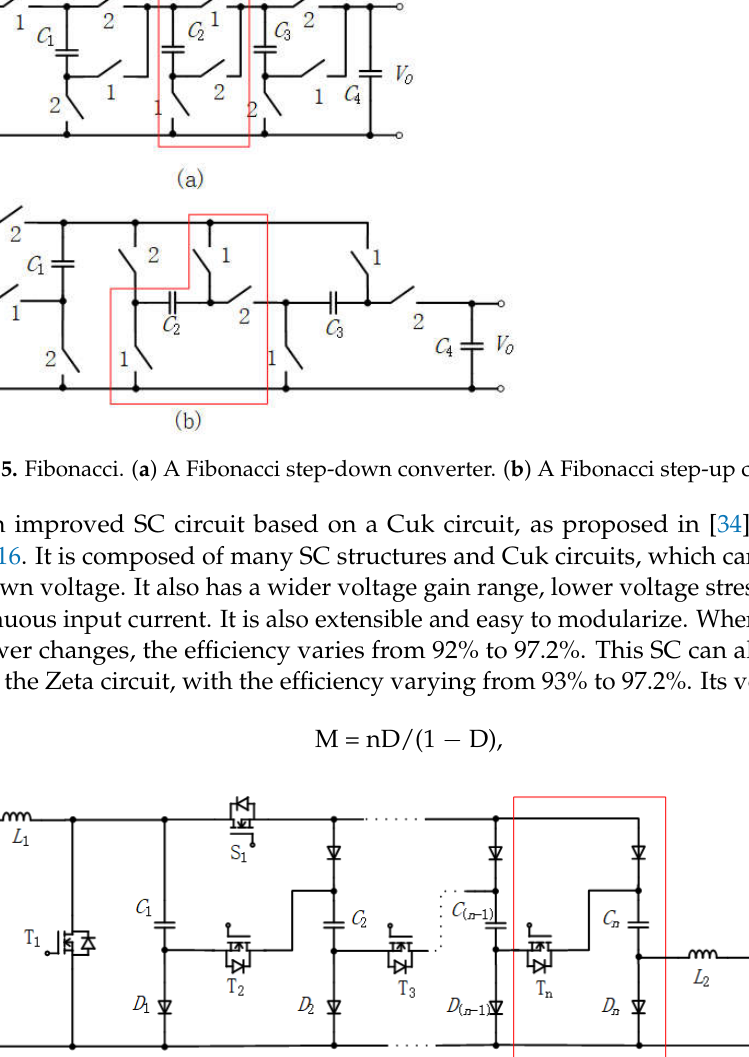
Figure 16. A Cuk-derived step-up/down SC converter in [34].